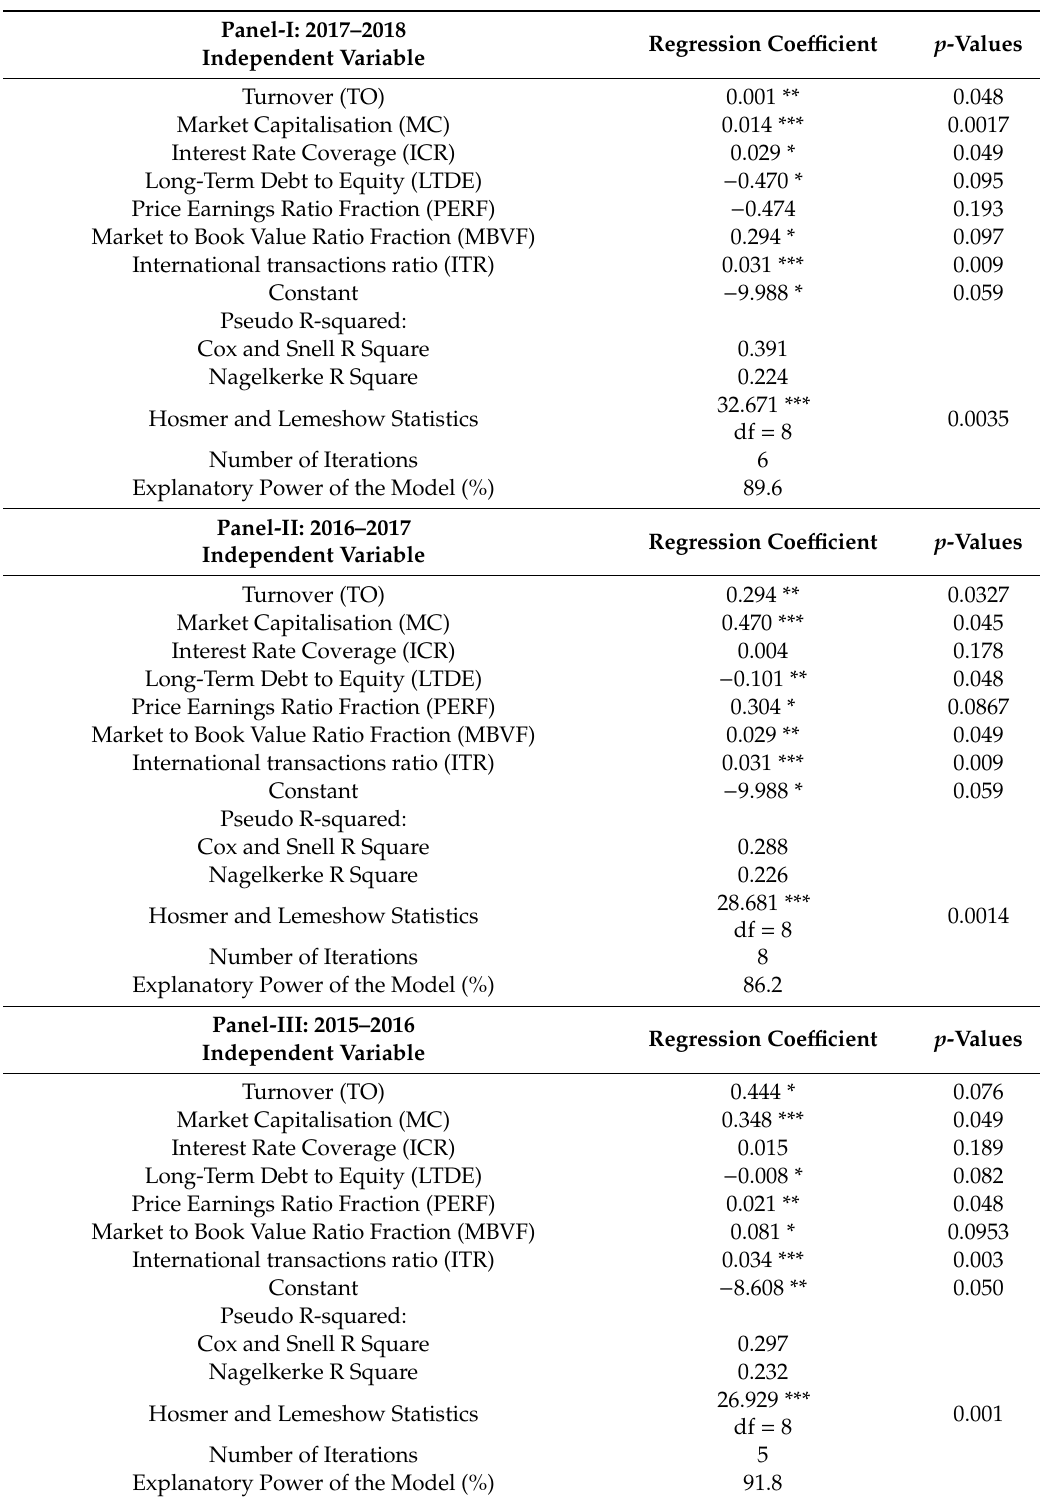
Table 3. Regression results determinants of derivative